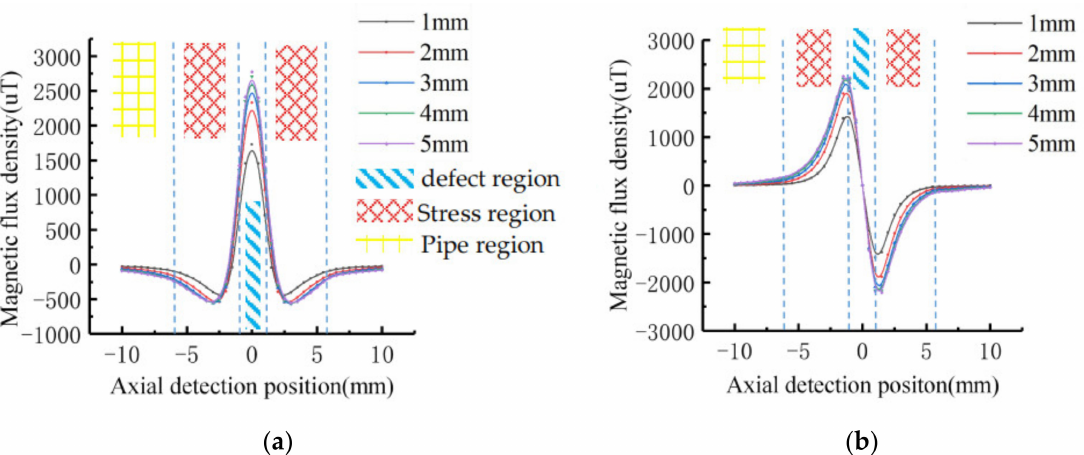
Figure 8. The MFL signals with stress operators at different depths: ( a ) Tangential signal; ( b ) Normal